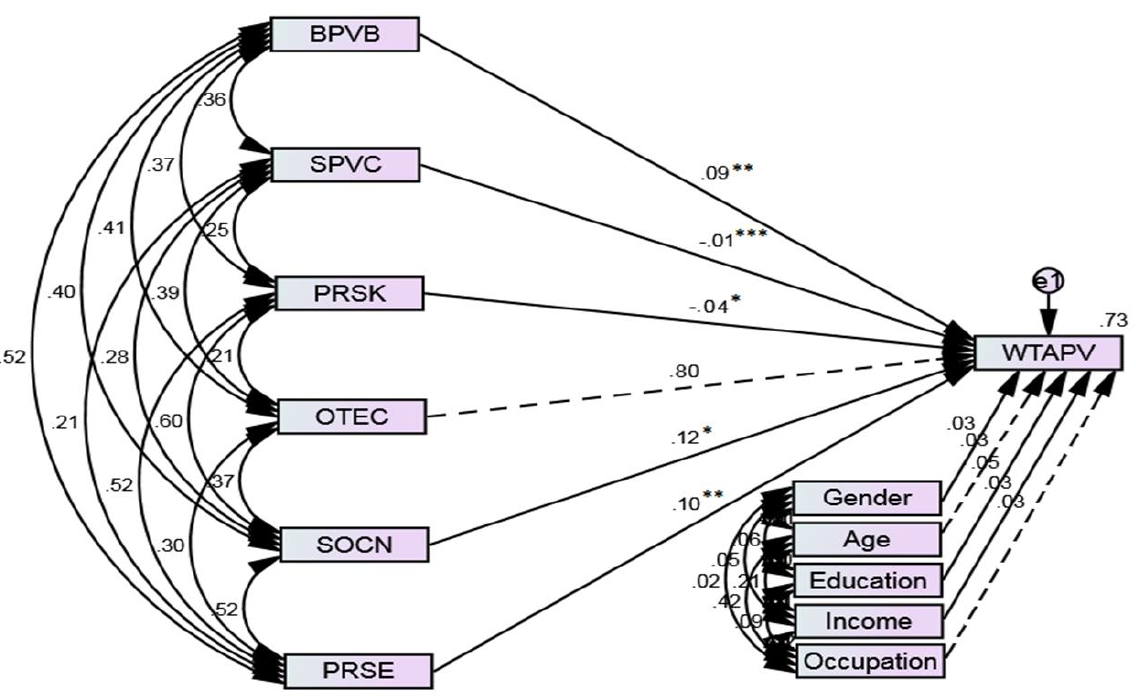
Figure 3. Diagram of structural model ’ s path. Notes: *** p < 0.00, ** p < 0.01, * p < 0.05. Table 12. Results of hypotheses.